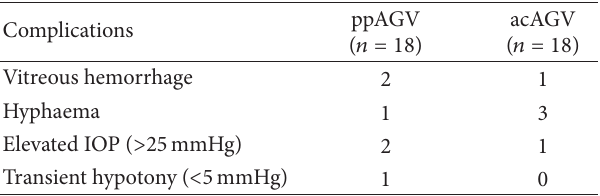
Table 4: Postoperative complications in the ppAGV and acAGV